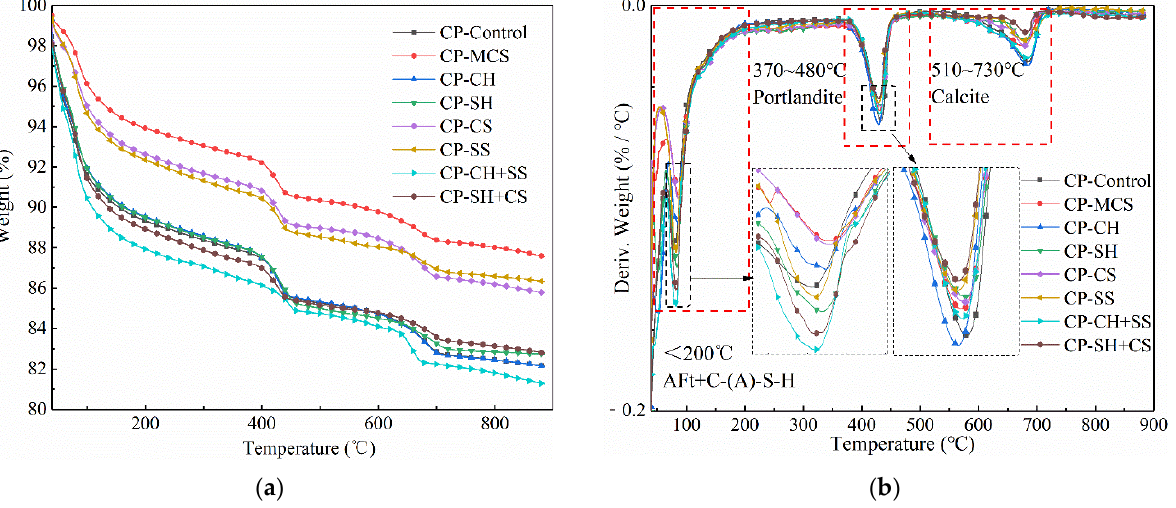
Figure 7. TGA-DTG curves of cement pastes: ( a ) TGA curves of cement pastes, ( b ) DTG curves of cement pastes.